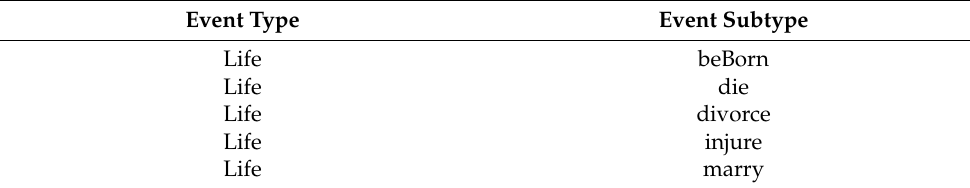
Table 1. Type and subtype for the Life events defined in the ERE